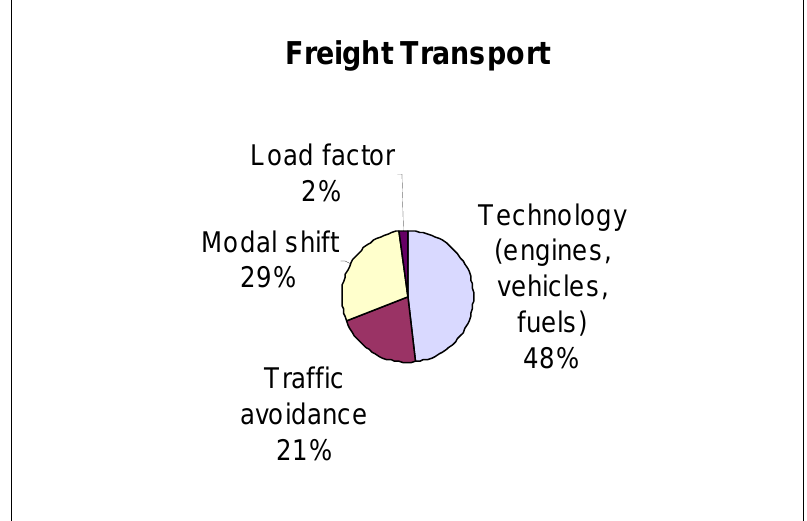
Figure 8: Impact of Measures to achieve the EST criteria If EST is to be achieved in the CEI region over the next three decades, policies and measures would have to be adopted that will result in transport in 2030 with the following